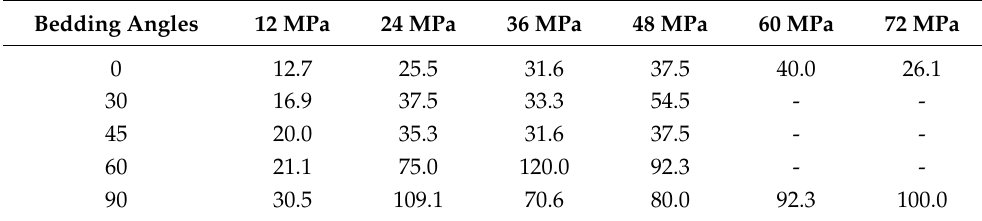
Table 11. Instantaneous elastic modulus of rock samples in a dry state at different stress levels. Bedding